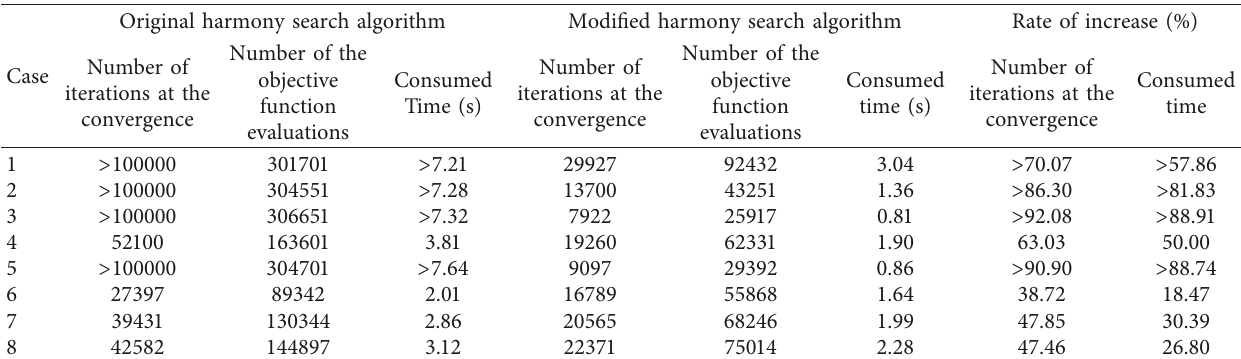
Figure 4: Contours of the damping deformation enhancement factor α of an SDOF structure with the inerter system (note: the black square in the figure represents the parameters optimized by the modified harmony search algorithm). (a) Case 3. (b) Case 4. (c) Case 7. (d) Case 5. Table 6: Average convergent iterations of modified and original harmony search